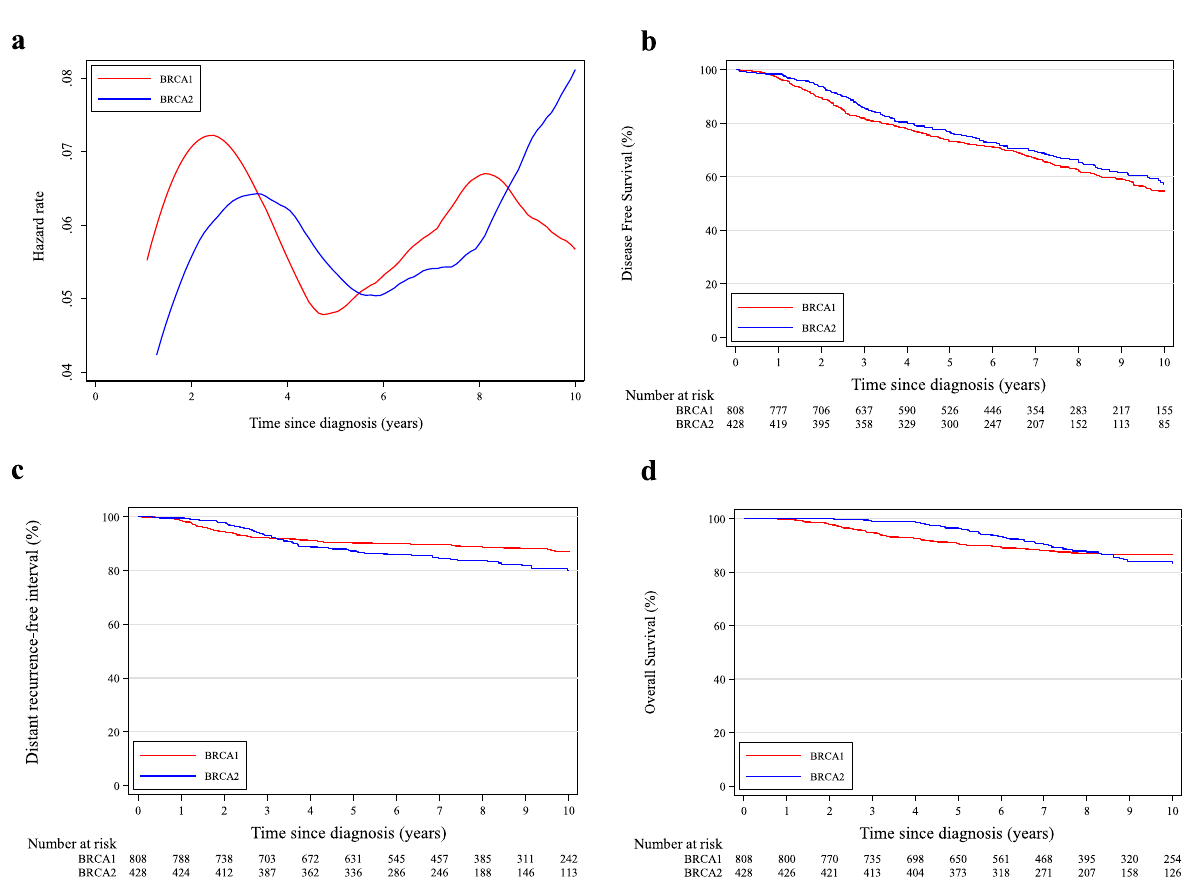
Fig. 1 Comparison between patients with germline BRCA1 and BRCA2 pathogenic variants. a Epanechnikov Kernel-Smoothed annual hazards of recurrence overall; b Disease-free survival; c Distant recurrence-free interval; d Overall